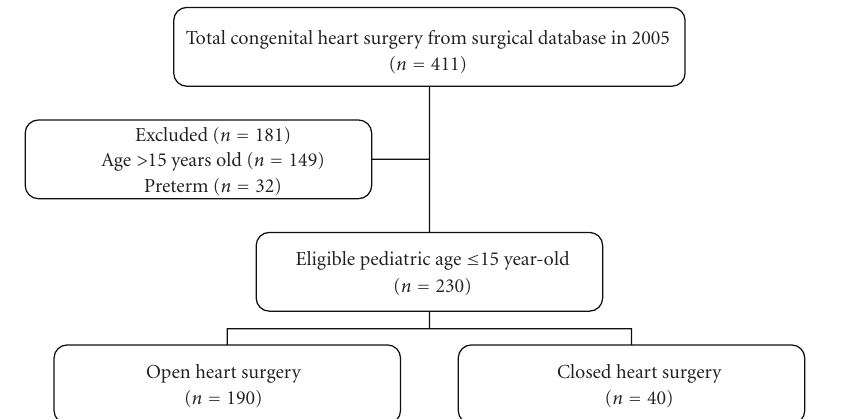
Figure 1: Flow chart of participants through the study.